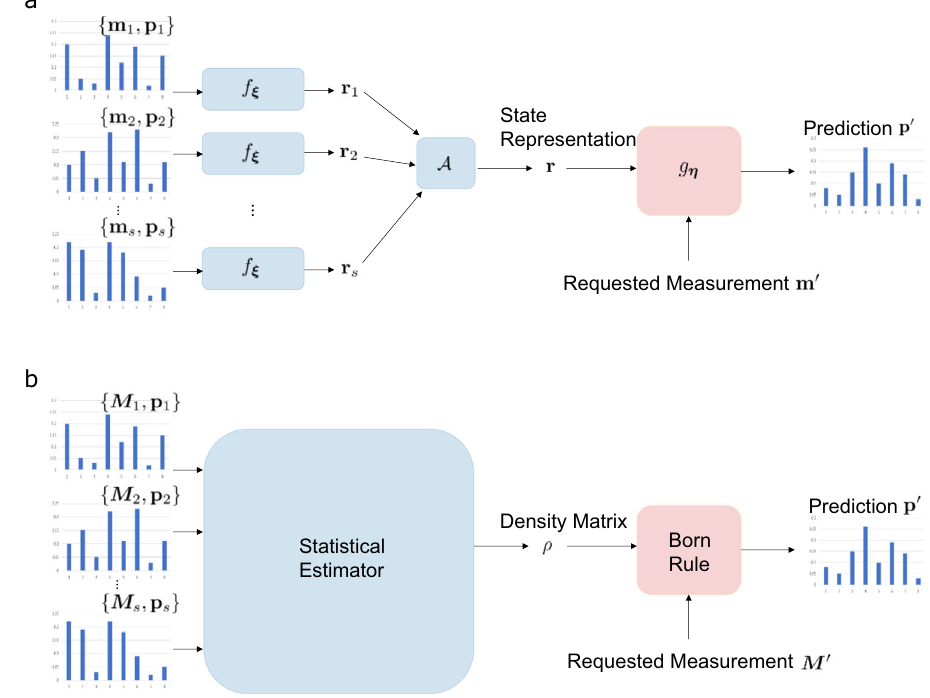
Fig.1|StructureofGQNQandcomparisonwithquantumstatetomography. In GQNQ ( a ), a representation network receives as input the raw measurement data fð m i , p i Þg s i =1 andproducesasoutput s vectors r i = f ξ ( m i , p i ),thatarecombinedintoa single vector r by an aggregate function A . The vector r serves as a concise representationof the quantum state, and issent toa generationnetwork g η , which predicts the outcome statistics p 0 of any desired measurement m 0 in the set of